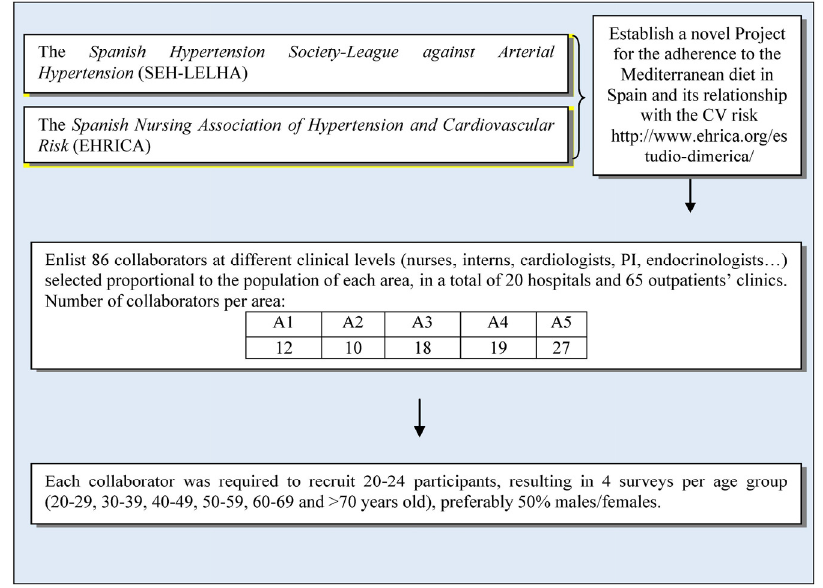
Figure 3. Process of volunteer recruitment.